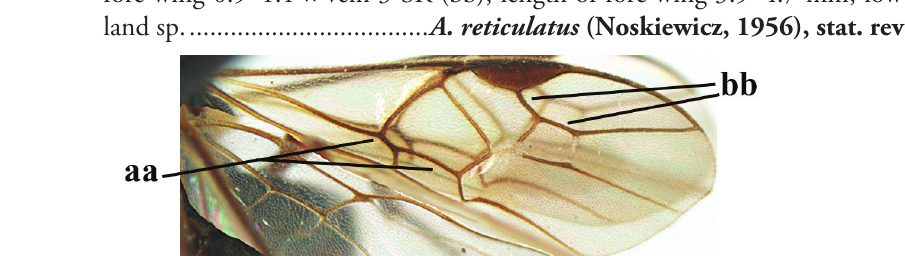
Vein M+CU1 of fore wing apically above level of vein 2-CU1 (aa); vein r of fore wing 0.9–1.1 × vein 3-SR (bb); length of fore wing 3.9–4.7 mm;